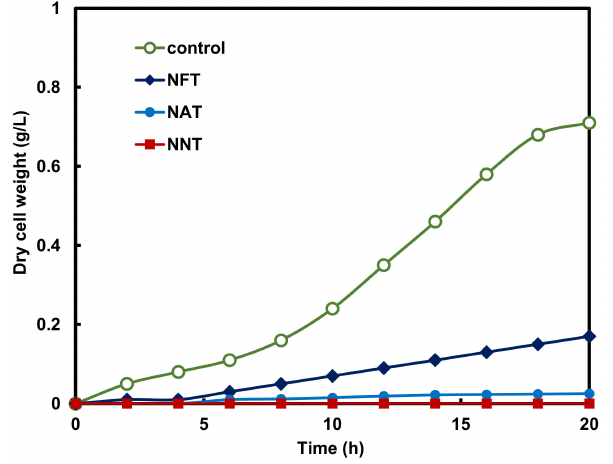
Figure 8. Variation of Pseudomonas aeruginosa concentration in the photolysis of various metal ion- doped TiO 2 photocatalysts under visible light irradiation.